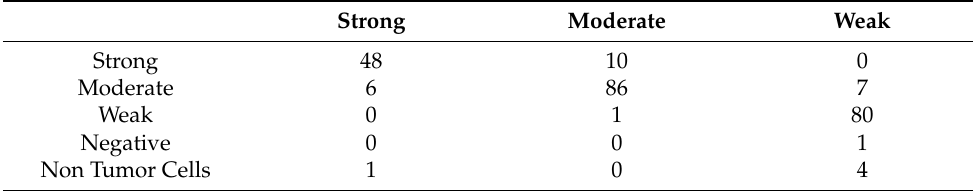
Table 6. WMS classification results.